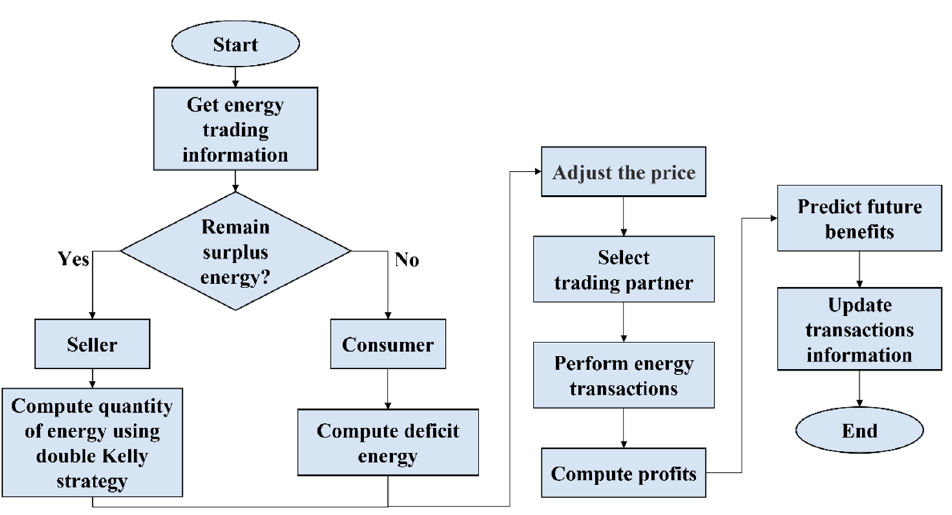
Figure 3. Flowchart of the proposed energy trading scheme.